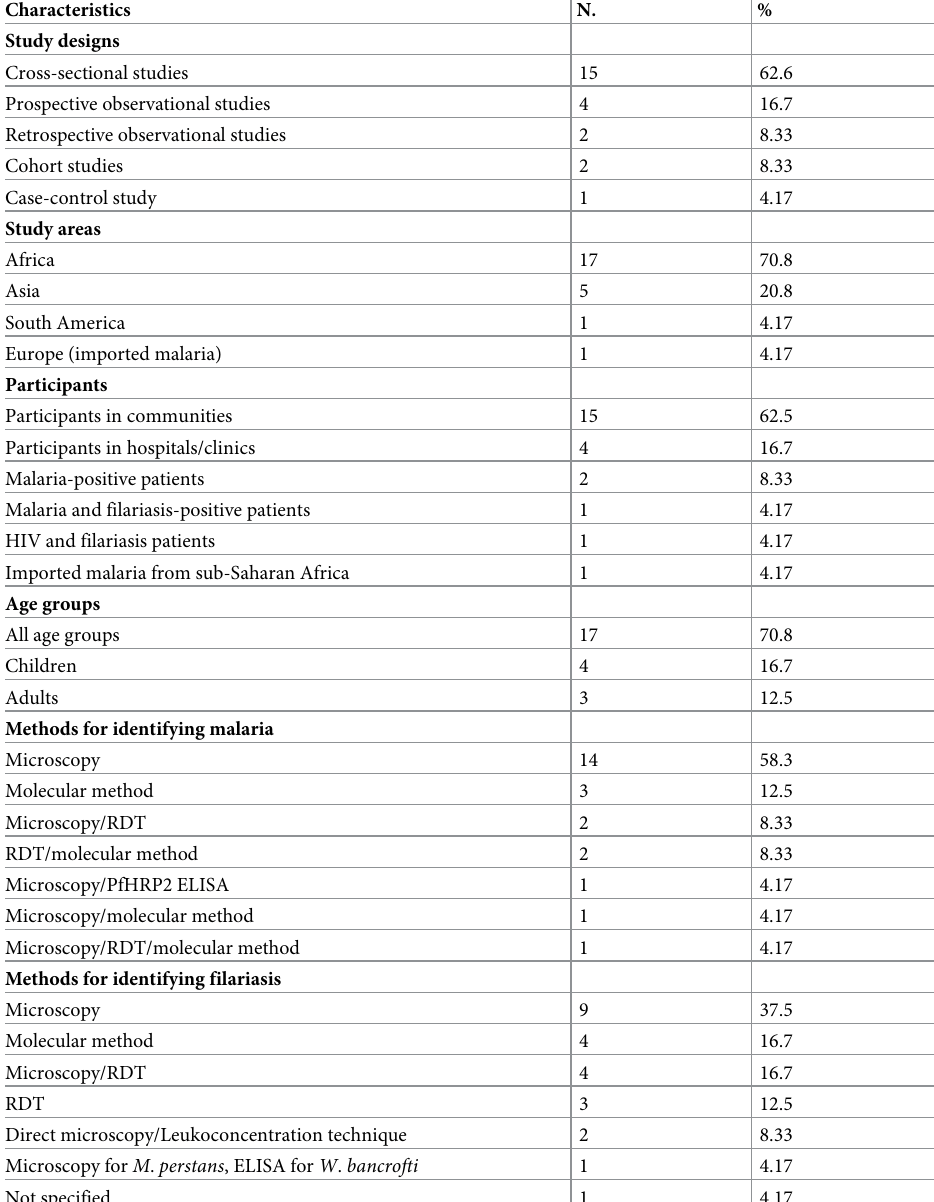
Table 1. Characteristics of 24 studies included in the study.